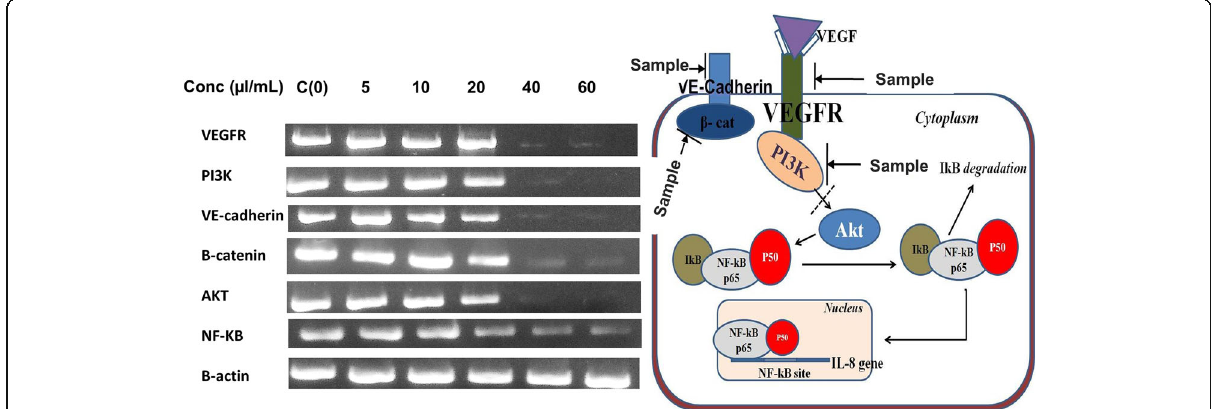
Fig. 4 Inhibitory effects of crude microcystins on mRNA expression level of VEGFR-2, PI3 K, β -Catenin, VE-Cadherin, Akt, and NF-kB analysed by RT-PCR b. The possible mechanisms of the inhibition of angiogenesis by the crude microcystins. We supposed and graphically described the mechanism of inhibition of angiogenesis by crude microcystin. 500 μ l microsytins were isolated from 10 ml M. aeruginosa culture (OD660 = 1.8) and then different volumes of the crude microcystins were (5 – 60 μ l/mL) used for the antiangiogenic